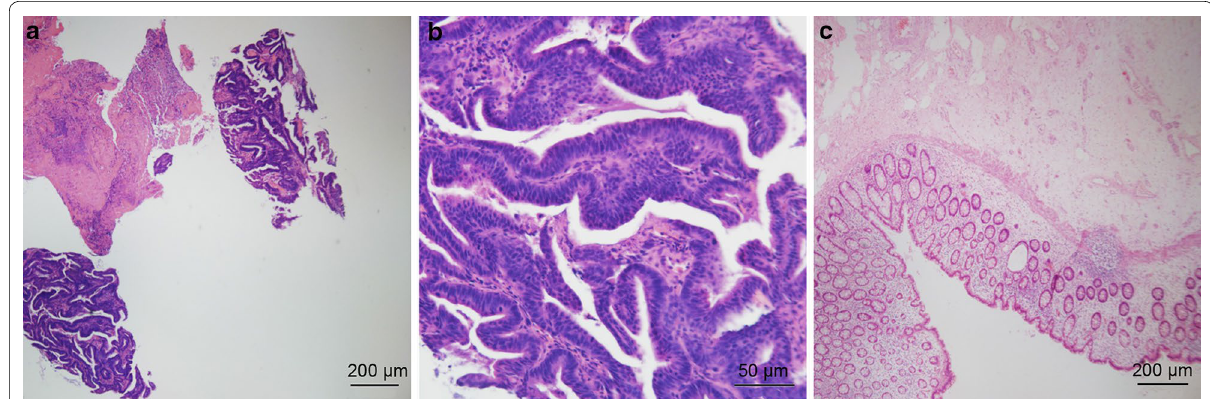
Fig. 2 The pathologic findings before neoCRT and after surgery of a patient with LASCC (hematoxylin and eosin staining). a , b Pathologic examina‑ tion of the sigmoid colon biopsy before neoCRT shows typical features of a well‑differentiated adenocarcinoma: hyperplastic glandular structures lined by atypical epithelial cells. Mitotic figures are observed. c Postoperative pathologic examination shows lymphoid infiltrates in intestinal mucosa. No malignant cells are